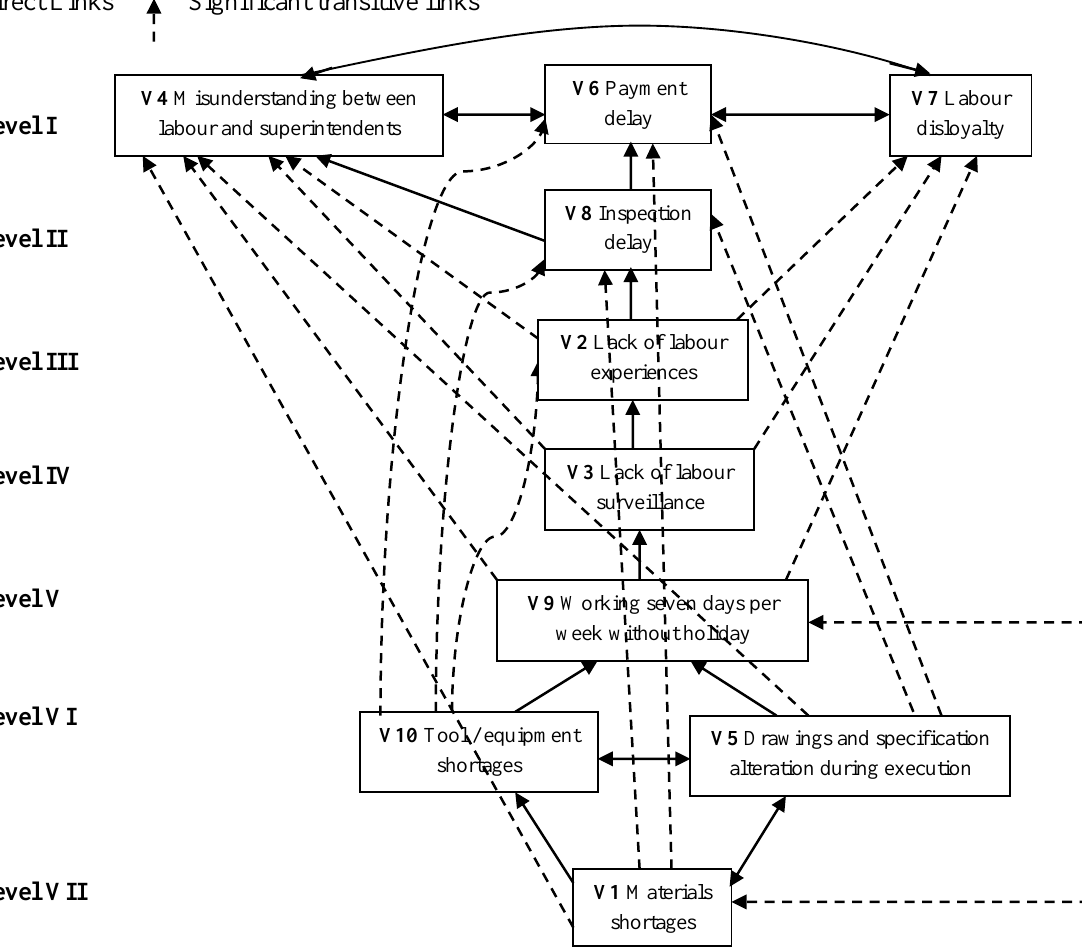
Figure 1 Diagraph for factors affecting construction labour productivity using